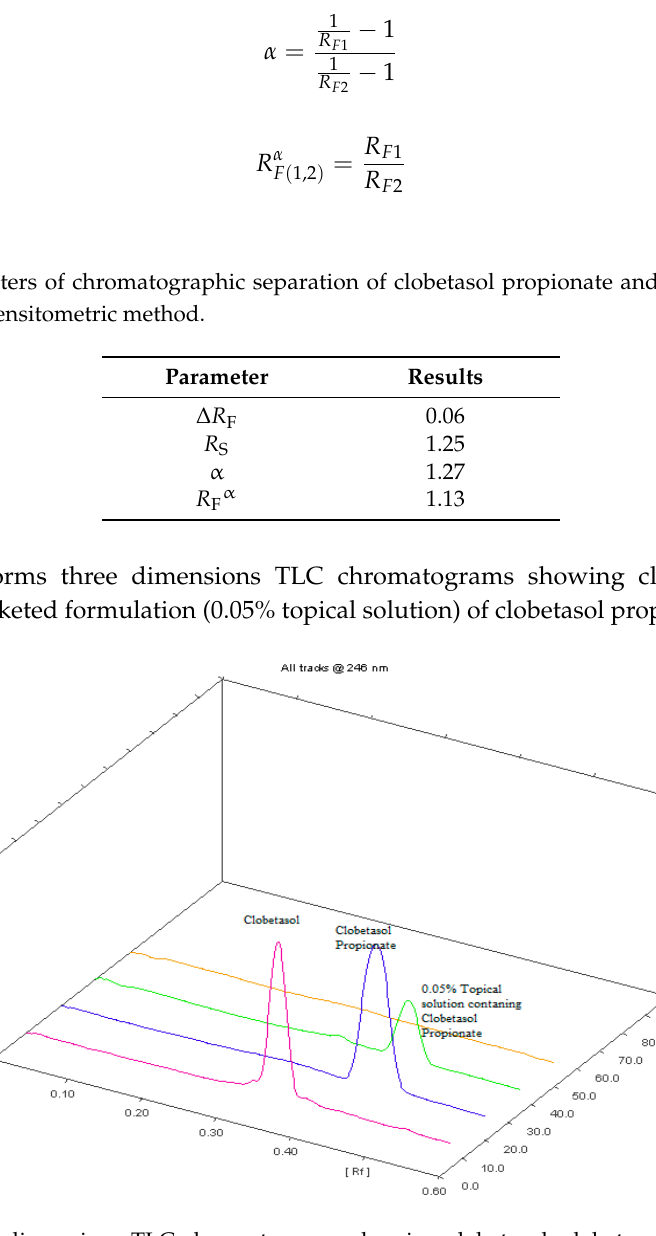
Figure 3. Three dimensions TLC chromatograms showing clobetasol, clobetasol propionate and marketed formulation (0.05% topical solution) of clobetasol propionate, respectively. Notes: